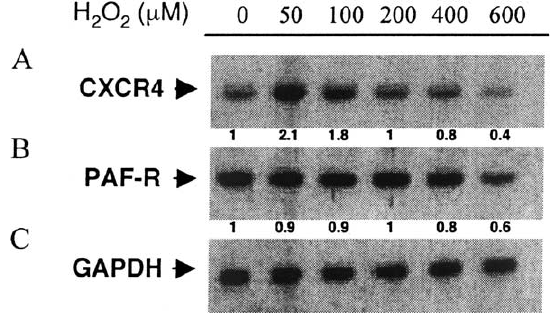
FIG. 1. Induction of CCR5 mRNA expression by H 2 O 2 in human monocytes. Human monocytes were incubated for 4 h with graded concentrations of H 2 O 2 in serum-free RPMI 1640 medium and total RNA was extracted and analysed by northern blotting for CCR5 mRNA expression. (A) Autoradio- gram of one representative experiment. (B) Densitometric quantification of CCR5 mRNA normalized to GAPDH mRNA. The results represent the means 9 / SEM of nine independent experiments. * p B / 0.05, H 2 O 2 -treated versus control cells.